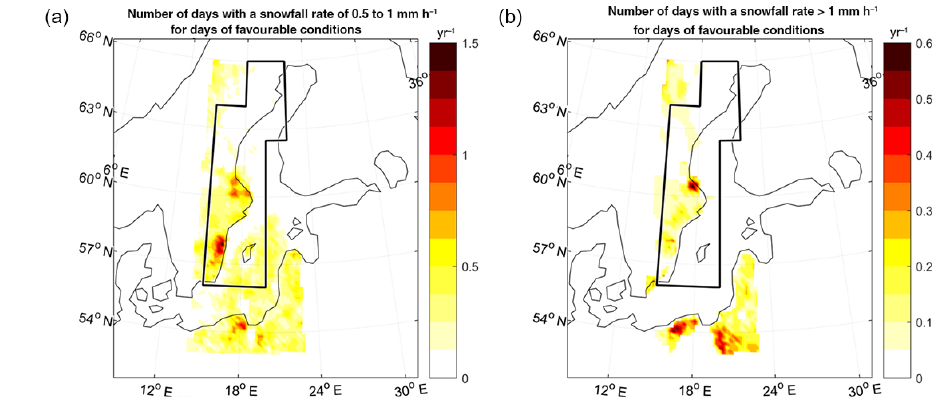
Figure 6. Frequency of occurrence of convective snow bands fulfilling the selection criteria for favourable atmospheric conditions (see